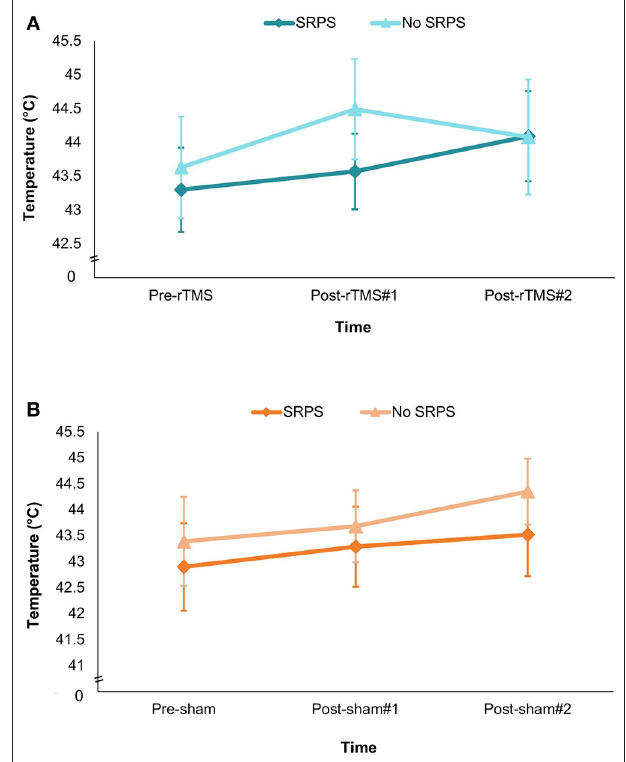
FIGURE 2 | Graph depicting fluctuations in heat pain threshold (mean T ◦ C) according to group × time (pre-interventions, between interventions and post-interventions) × SRPS exposition. (A) rTMS visit. (B) Sham visit. Results are expressed as means and standard errors (SEM). HPT, heat pain